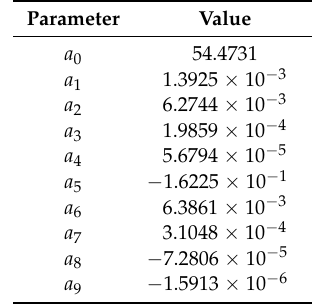
Table 3. New Coefficients of the Model for Excess Emissivity Due to Wind.